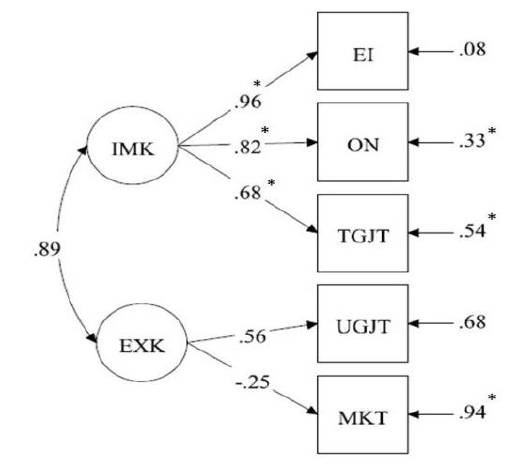
CFA Model 1 based on data from Bowles